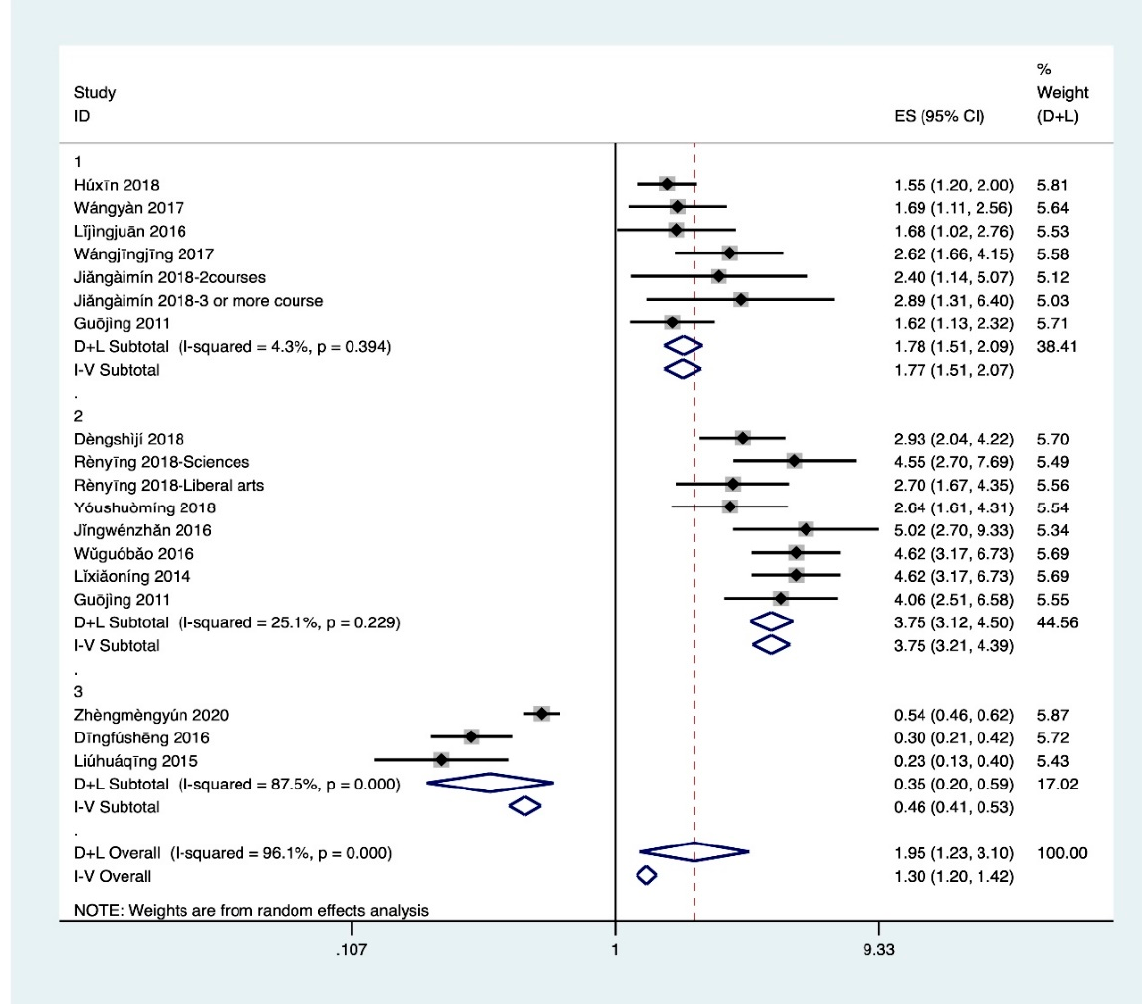
Figure 5. Meta for SE. 1: health education courses; 2: major; 3: school type.